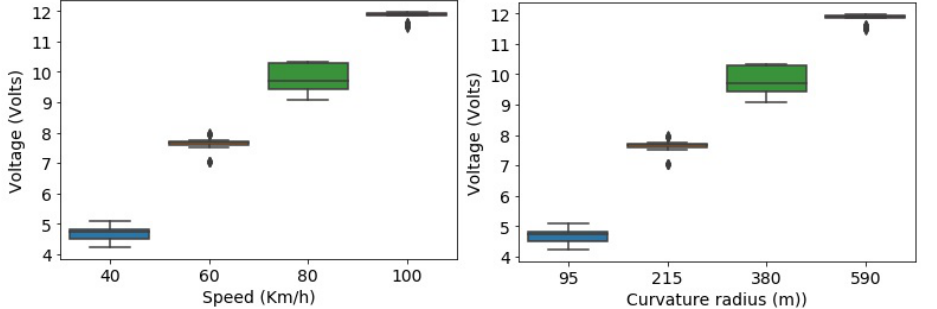
Figure 10. Relationship between